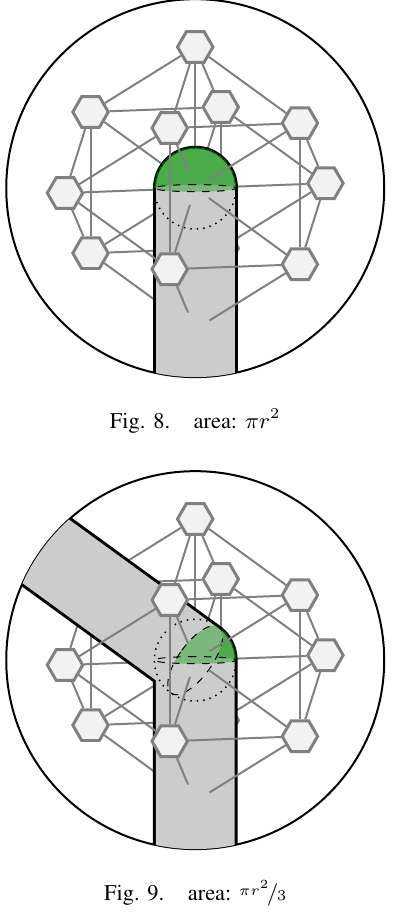
Fig. 9. area: πr 2 / 3